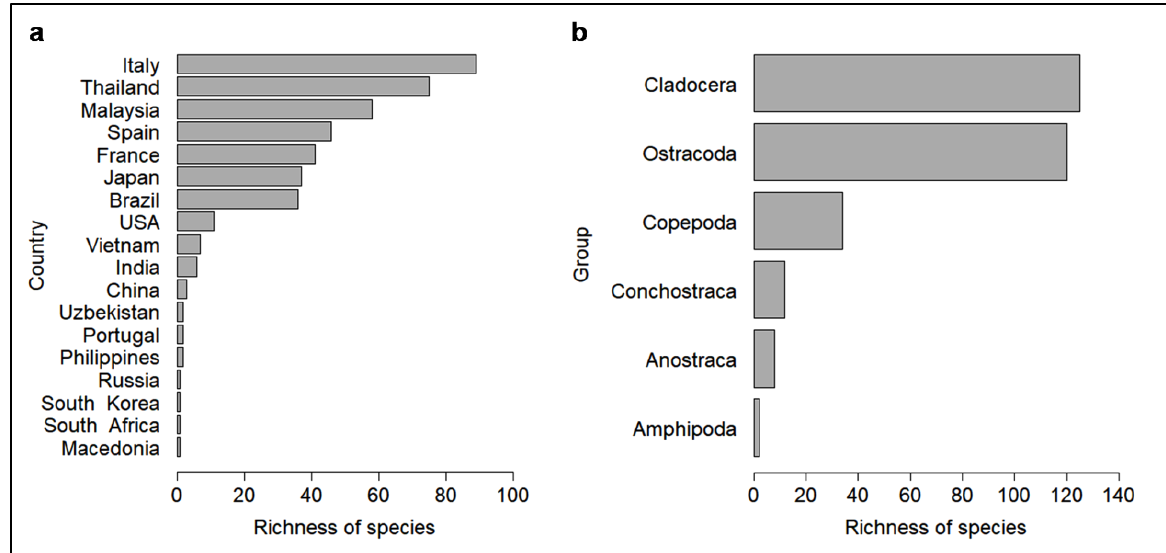
Figure 4. Richness of microcrustaceans found in studies in rice fields indexed in the Web of Science and Scopus databases between the years 1977 and 2019: (a) richness in countries and (b) richness by group. USA = United States of